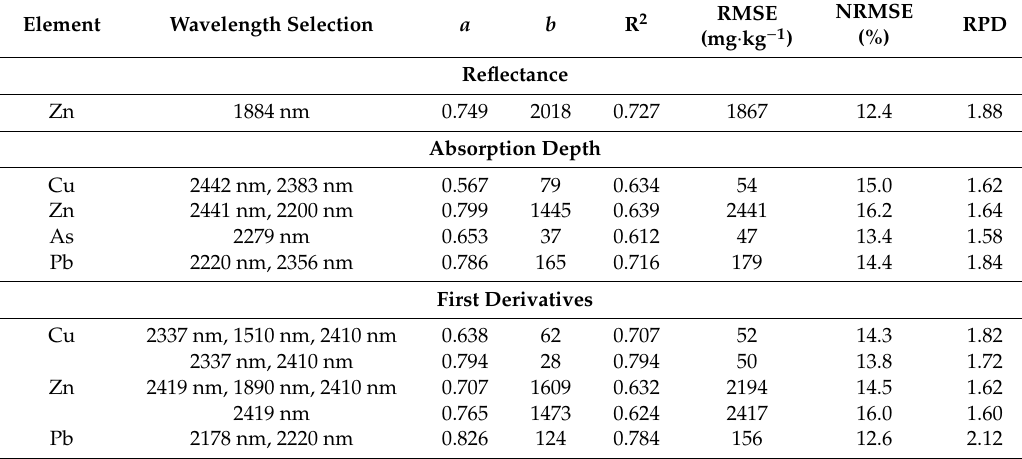
Table 6. Parameter for fitting measured heavy metal concentration to the predicted heavy